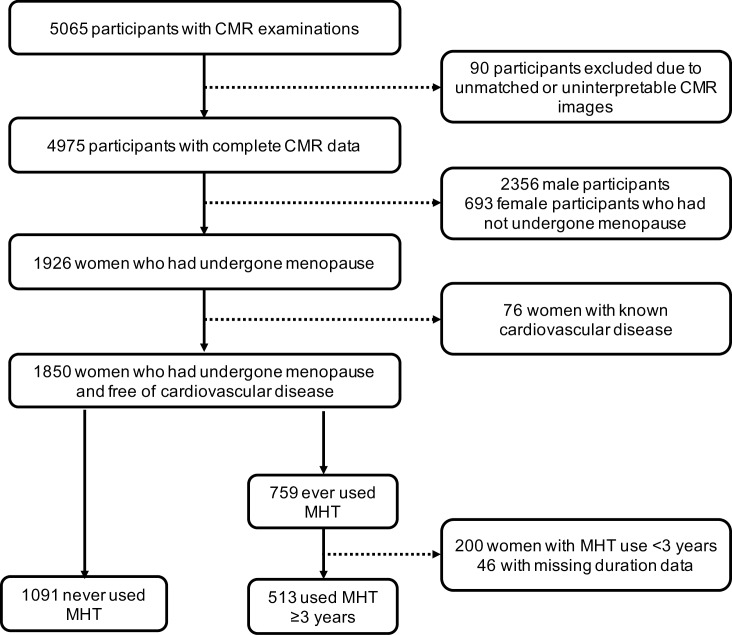
Case selection flowchart.